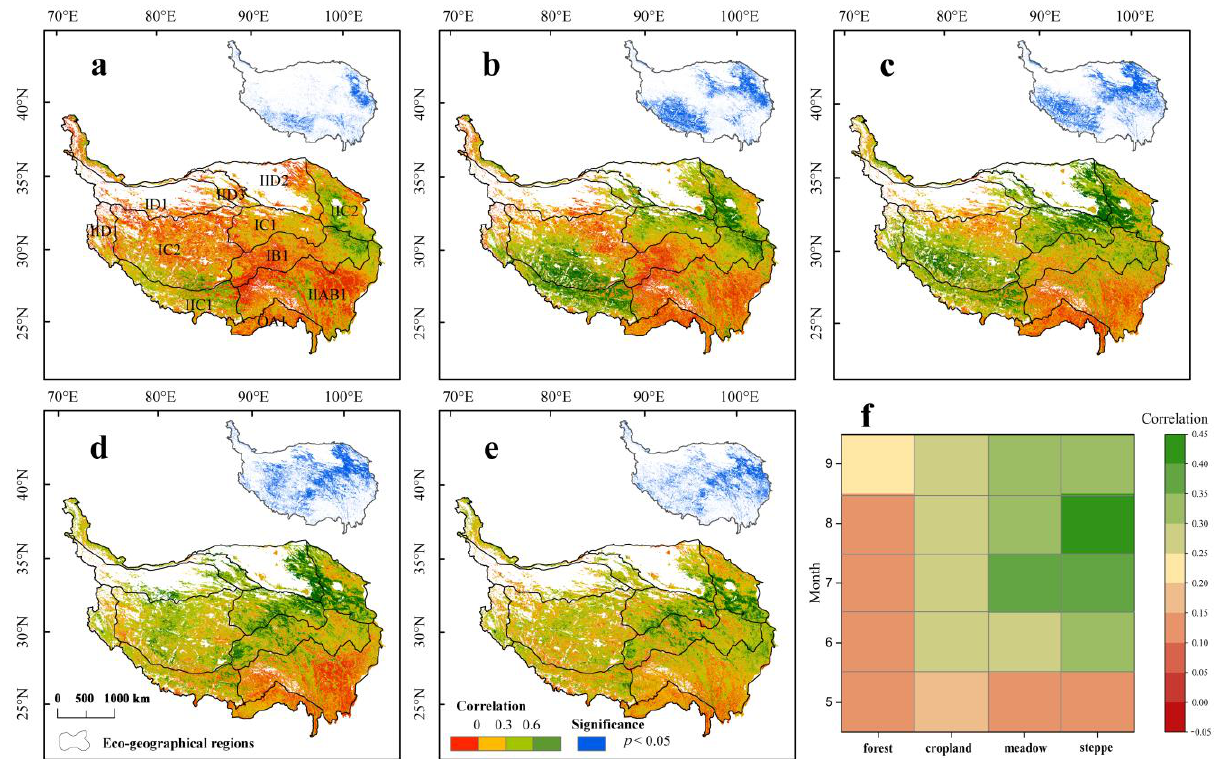
Figure 5. Spatial pattern of the largest correlation coefficient r max − cum between SPEI and NDVI and Figure 5 . Spatial pattern of the largest correlation coefficient r max−cum between SPEI and NDVI and significance ( p < 0.05) from 2000 − 2018. ( a ) May; ( b ) June; ( c ) July; ( d ) August; ( e ) September. The significance ( p < 0.05) from 2000−2018. ( a ) May; ( b ) June; ( c ) July; ( d ) August; ( e ) September. The largest correlation coefficient r max − cum between SPEI and NDVI of different vegetation types on the largest correlation coefficient r max−cum between SPEI and NDVI of different vegetation types on the QTP ( f QTP ( f ) .